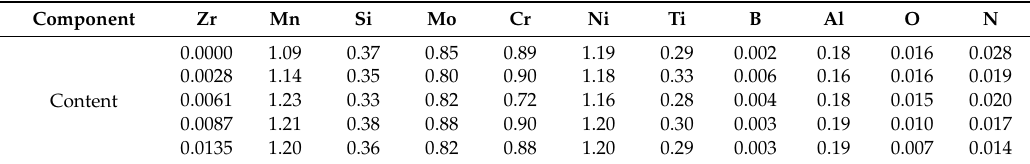
Figure 3. Schematic diagram of the ball drop test machine.